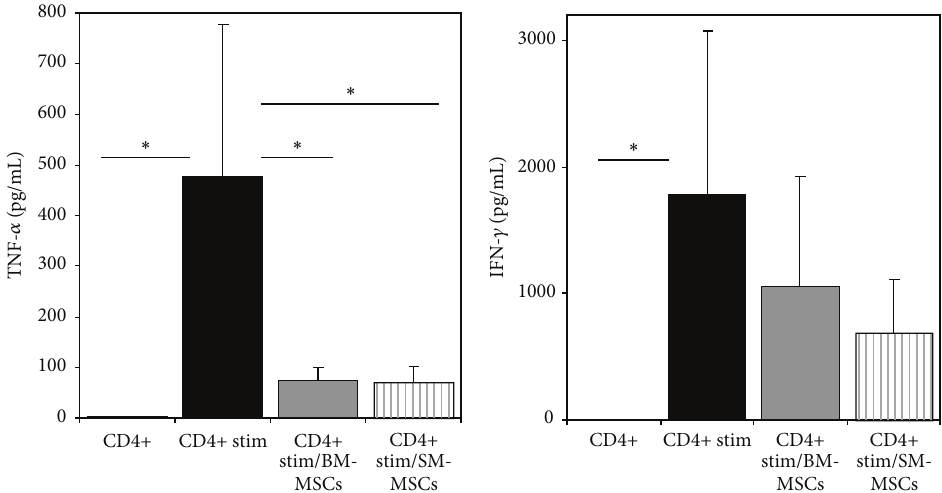
Figure 5: Cytokine levels in CD3/CD28- stimulated and control CD4+ T-cells and the respective MSC cocultures. CD3/CD28 stimulation resulted in an increase of IL-2, IL-4, IL-6, IL-10, IL-17a, TNF- 𝛼 , and IFN- 𝛾 secretion. While for IL-2 and TNF- 𝛼 cocultivation with MSCs resulted in a significant decrease in CD4+ T-cell cytokine secretion, a significant increase in IL-6 secretion in unstimulated and stimulated cocultures could be observed. Due to the high IL-6 levels in the stimulated cocultures, this diagram is displayed with a logarithmic 𝑦 -scale. ∗ 𝑝 < 0.05 , ∗∗ 𝑝 < 0.01 , ∗∗∗ 𝑝 < 0.001